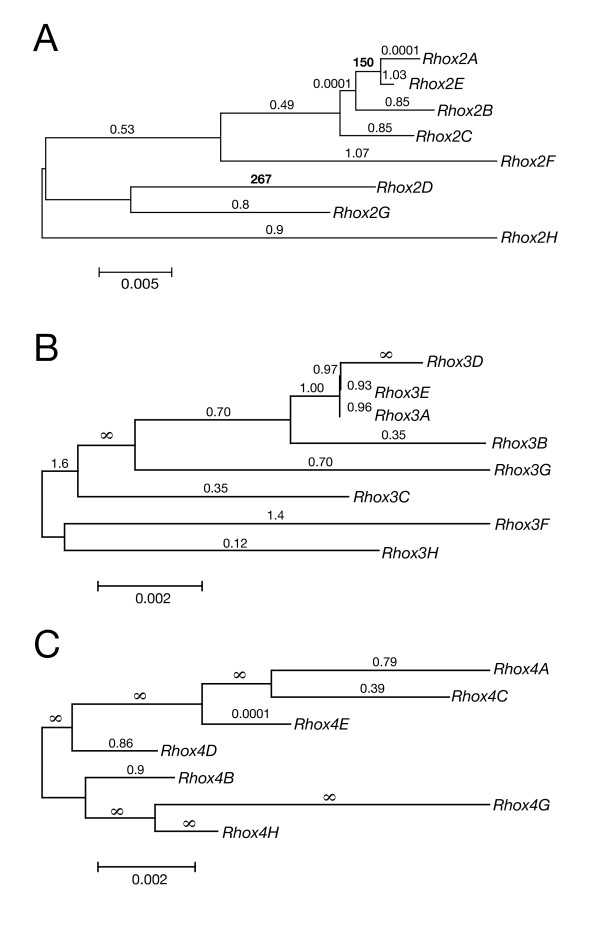
A, B & C. Phylogeny of the Rhox2 (A), Rhox3 (B) and Rhox4 (C) paralogues. The numbers shown along each branch are the maximum likelihood estimates of the ratio of nonsynonymous and synonymous substitutions for the entire gene along that branch. Data for a "free-ratio" model is shown which allows for a different dN/dS ratio (parameter ω) for each branch in the tree. Branches are drawn in proportion to estimates of their lengths.